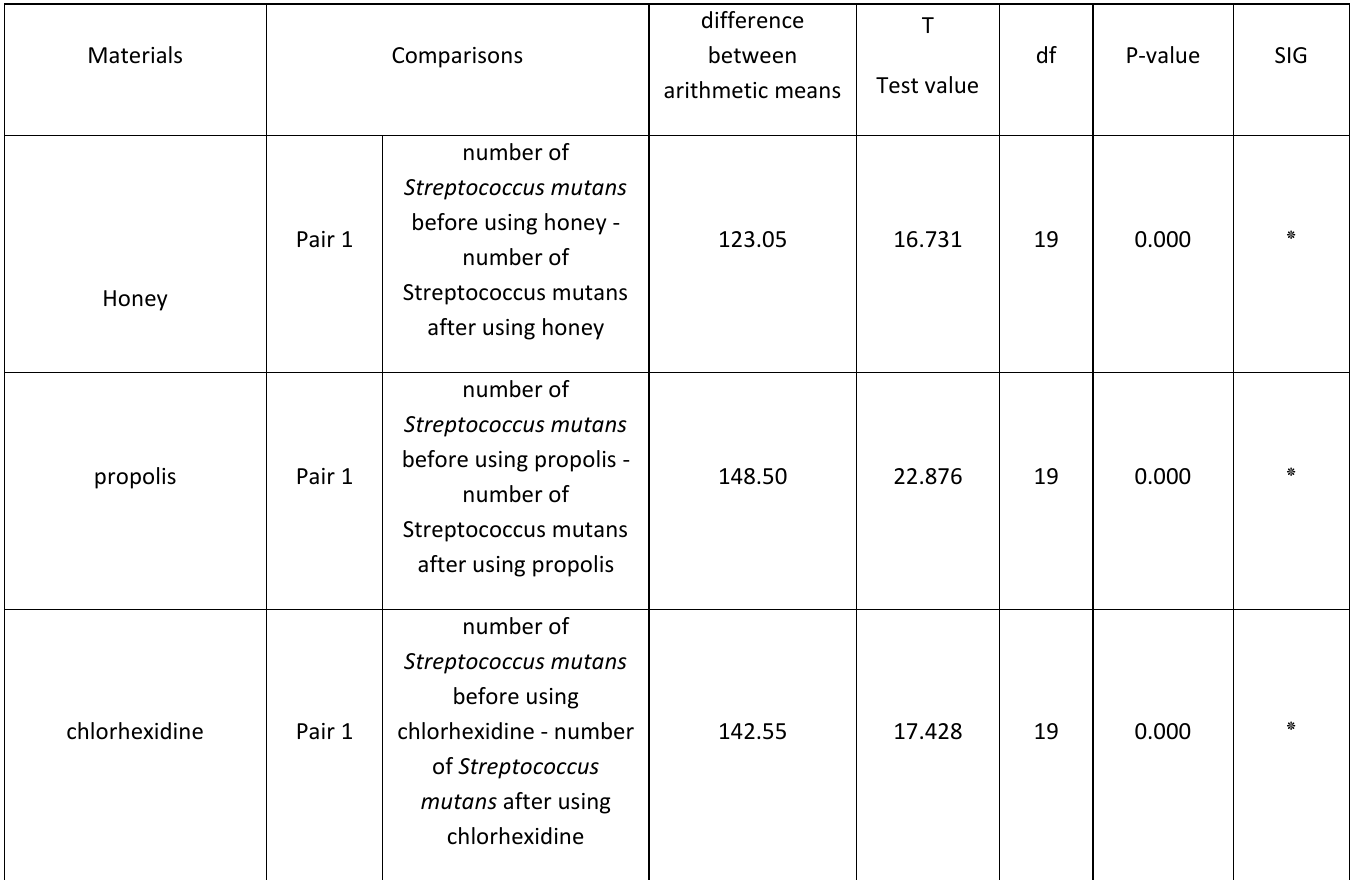
Table No. 2. Results of using Paired Samples T Test when comparing the arithmetic means of the number of Streptococcus mutans before and after the